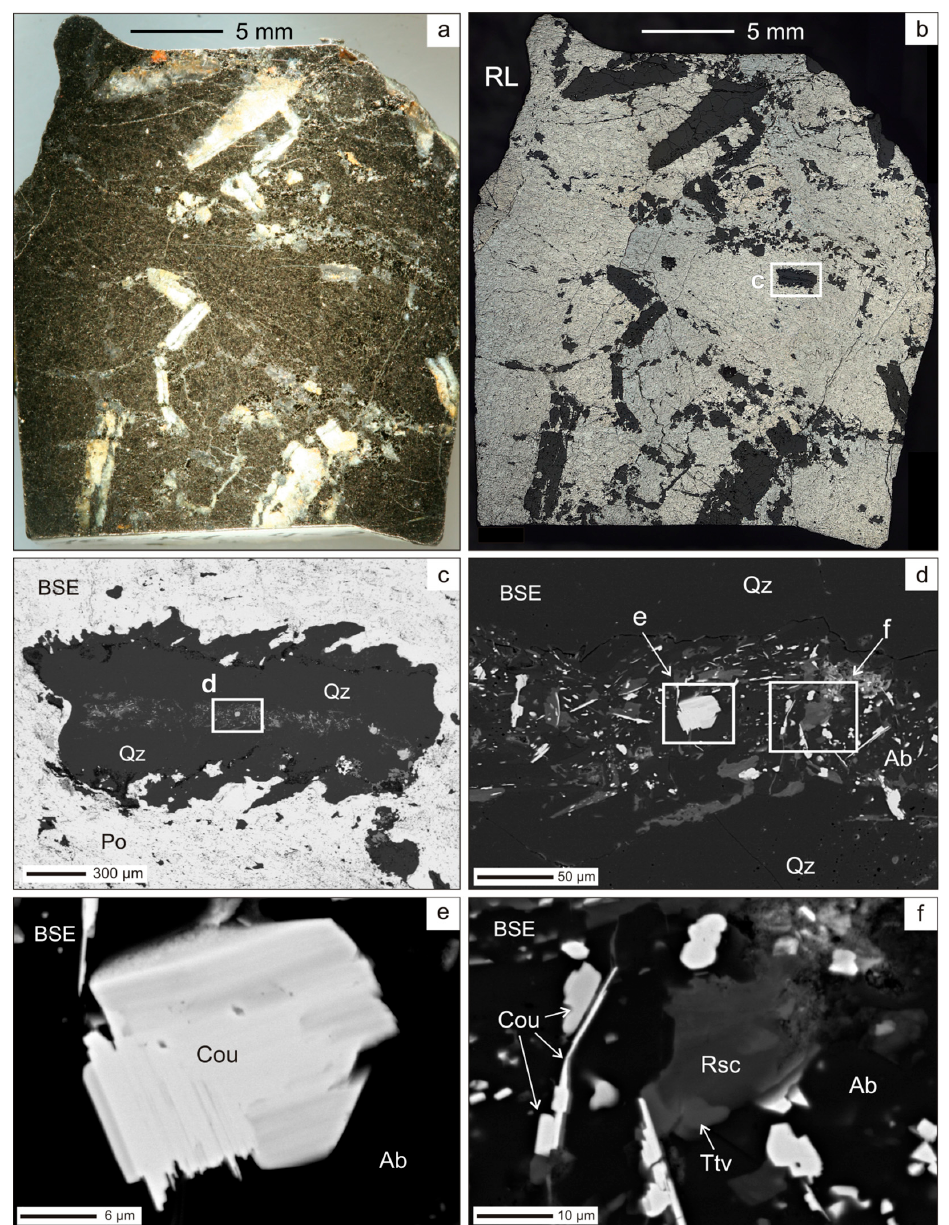
Figure 6. Appearance of a massive sulfide ore containing relics of quartz-albite veins in polished sample 16-K7-4-2 in ordinary ( a ) and reflected ( b ) light. ( c ) Zonal and banded structure of an elongated relic. ( d – f ) Internal structure ( d ) and mineralogy of the axial albite band ( f ). BSE and RL, back-scattered electron and reflected light images, respectively; Ab, albite; Cou, coulsonite; Qz, quartz; Rsc, roscoelite; Ttv,